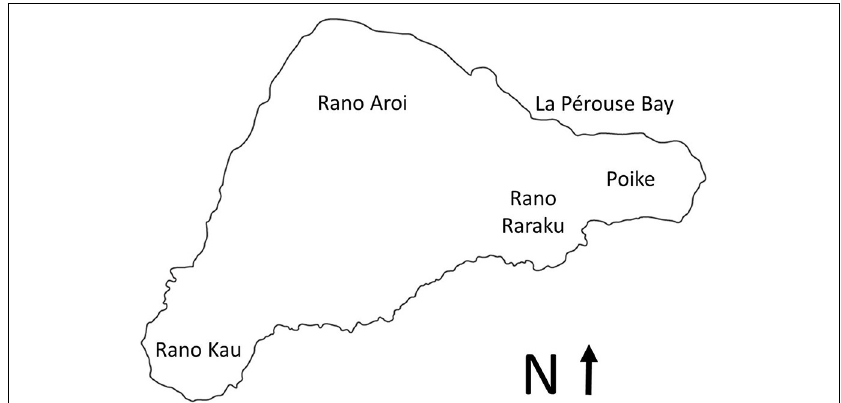
FIGURE 1 | Locations on Rapa Nui (Easter Island) referred to in this